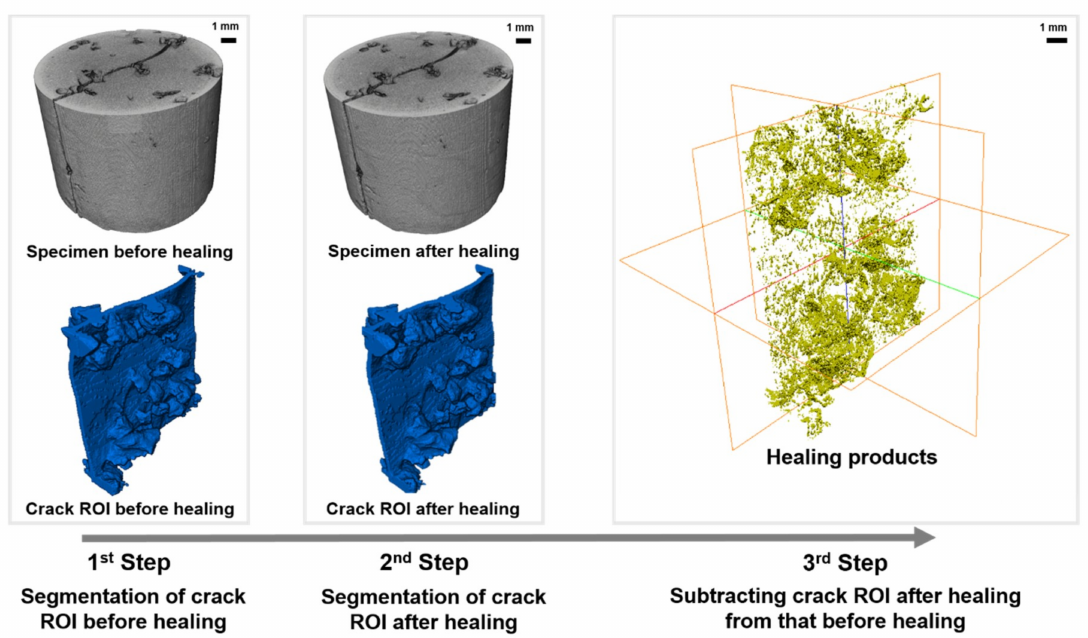
Figure 11. Segmentation of healing products in the crack